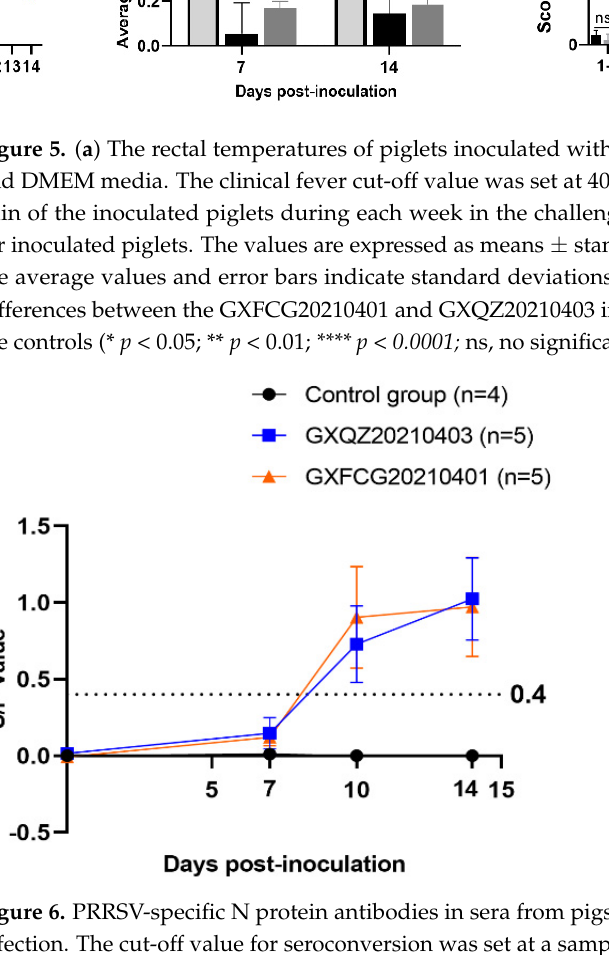
Figure 6. PRRSV-specific N protein antibodies in sera from pigs challenged for different days after infection. The cut-off value for seroconversion was set at a sample-to-positive (s/p) ratio of 0.4. The values are expressed as means ± standard deviations.